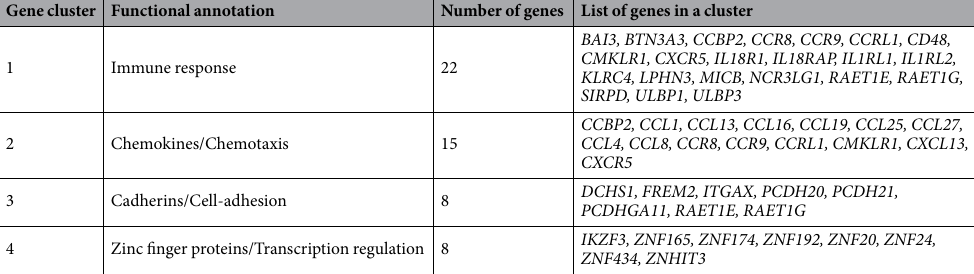
Table 1. Clusters of functionally-related genes characterised in the childhood-onset asthma module using DAVID 13, 41